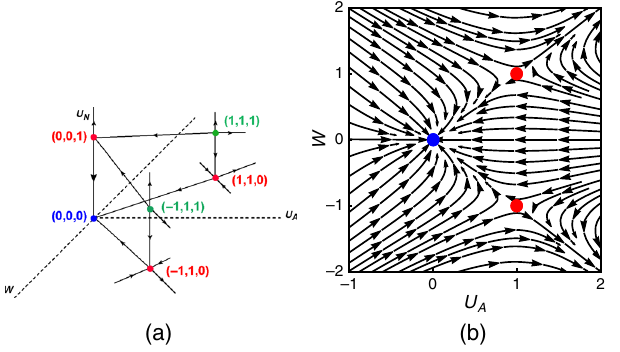
FIG. 9. (a) A schematic representation of the renormalization ; group flow in three-dimensional coupling constant space ð W; U ; W Þ plane in the strict A A ˆ Δ U for renormalized band parameter ð l Þ ¼ 0 . The stable non- N Þ interacting anisotropic semimetal fixed point at (0,0,0) is shown in blue; the quantum critical points at (0,0,1) and ð(cid:2) 1 ; 1 ; 0 Þ are shown in red; and the remaining two bicritical points at ð(cid:2) 1 ; 1 ; 1 Þ are shown in green. The coupling constants are measured in units of ϵ (see also Table III). (b) Deformation of the flow diagram from ; W Þ plane, upon incorporating the negative Fig. 8 in the ð U A engineering dimension ( − ϵ ) for the interaction couplings [see Eq. (32)]. Recall that all the fixed points have one additional ˆ Δ unstable direction along , which controls the transition between a Dirac semimetal and band